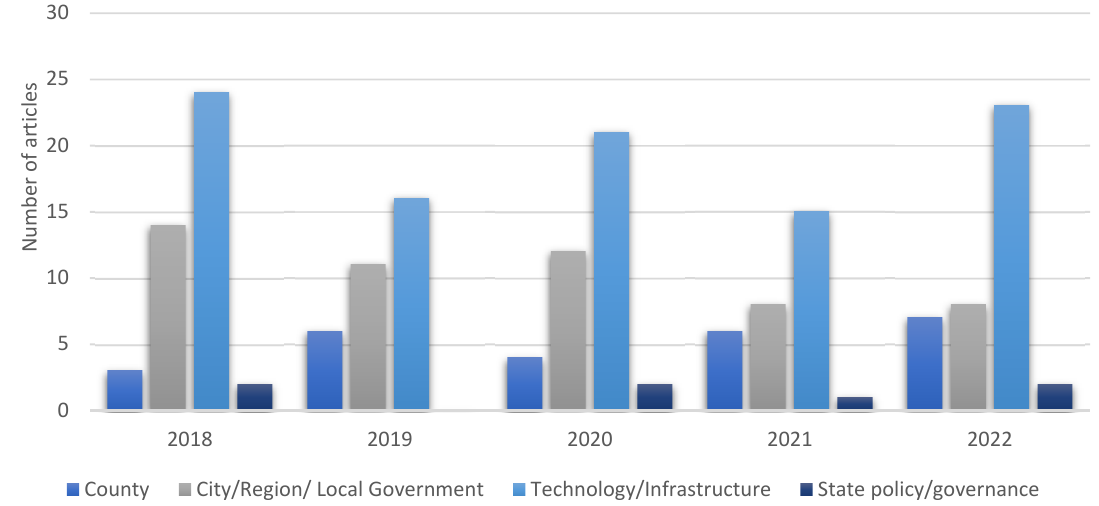
Figure 1. Classification of the researched articles according to the selected thematic areas.